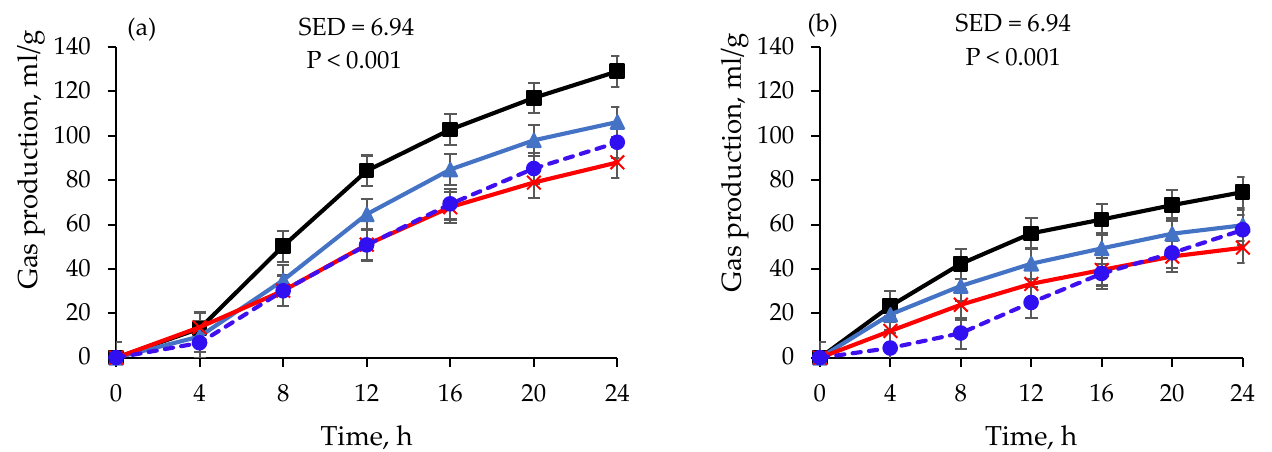
Time, h Figure 2. Gas production curves for 24 h incubation of feedstuffs (( a ) wheat grain and ( b ) lucerne Figure 2. Gas production curves for 24 h incubation of feedstu ff s (( a ) wheat grain and ( b ) lucerne Figure 2. Gas production curves for 24 h incubation of feedstu ff s (( a ) wheat grain and ( b ) lucerne Figure 2. Gas production curves for 24 h incubation of feedstu ff s (( a ) wheat grain and ( b ) lucerne Figure 2. Gas production curves for 24 h incubation of feedstu ff s (( a ) wheat grain and ( b ) lucerne Figure 2. Gas production curves for 24 h incubation of feedstu ff s (( a ) wheat grain and ( b ) lucerne hay) at 39 ◦ C using fresh rumen fluid on day 1 ( hay) at 39 °C using fresh rumen fl uid on day 1 ( ) and rumen fl uid treated with DMSO and hay) at 39 °C using fresh rumen fl uid on day 1 ( ) and rumen fl uid treated with DMSO and hay) at 39 °C using fresh rumen fl uid on day 1 ( ) and rumen fl uid treated with DMSO and hay) at 39 °C using fresh rumen fl uid on day 1 ( ) and rumen fl uid treated with DMSO and hay) at 39 °C using fresh rumen fl uid on day 1 ( ) and rumen fl uid treated with DMSO and kept at D − 20 °C for 14 days ( ), 30 days ( ), and 180 days ( ) at varying incubation kept at D − 20 °C for 14 days ( ), and 180 days ( ) at varying incubation kept at D − 20 °C for 14 days ( ), 30 days ( ), and 180 days ( ) at varying incubation kept at D − 20 °C for 14 days ( ), 30 days ( ), and 180 days ( ) at varying incubation kept at D − 20 °C for 14 days ( ), 30 days ( ), and 180 days ( ) at varying incubation times. Data at day 1 are for fresh rumen fl uid. Data are least-square means of gas production after times. Data at day 1 are for fresh rumen fl uid. Data are least-square means of gas production after times. Data at day 1 are for fresh rumen fl uid. Data are least-square means of gas production after times. Data at day 1 are for fresh rumen fl uid. Data are least-square means of gas production after times. Data at day 1 are for fresh rumen fluid. Data are least-square means of gas production after times. Data at day 1 are for fresh rumen fl uid. Data are least-square means of gas production after converting gas pressure into gas volume using Avogadro’s law. converting gas pressure into gas volume using Avogadro’s law. converting gas pressure into gas volume using Avogadro’s law. converting gas pressure into gas volume using Avogadro’s law. converting gas pressure into gas volume using Avogadro’s converting gas pressure into gas volume using Avogadro’s law.